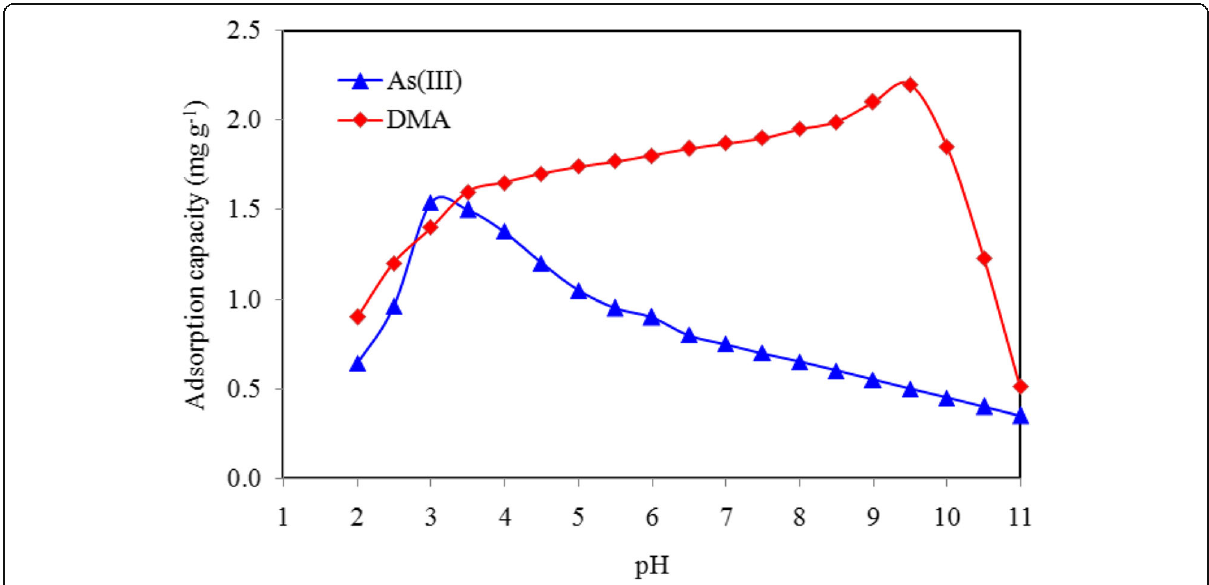
Fig. 5 Effect of different pH on the arsenic adsorption performance